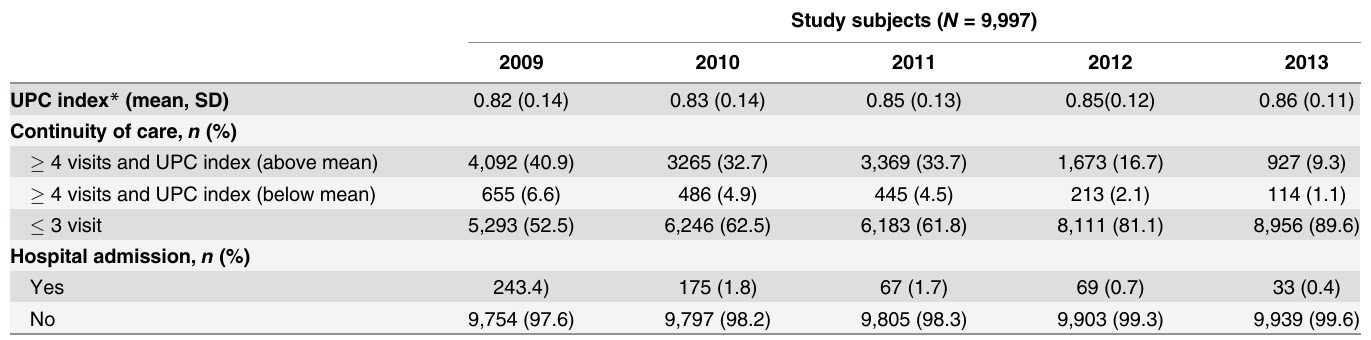
Table 2. Continuity of care and hospital admissions, by year.